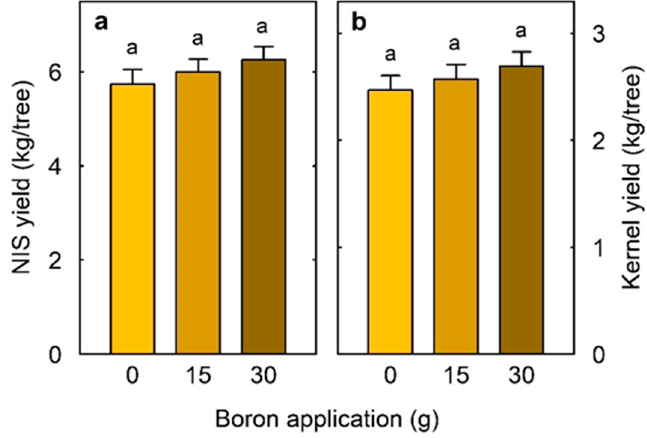
Figure 3. ( a ) Nut-in-shell (NIS) yield and ( b ) kernel yield of macadamia cultivar ‘816’ trees treated with 0, 15 or 30 g B prior to flowering. Means (+SE) do not differ significantly (generalised linear models, p > 0.05, n = 10 trees).